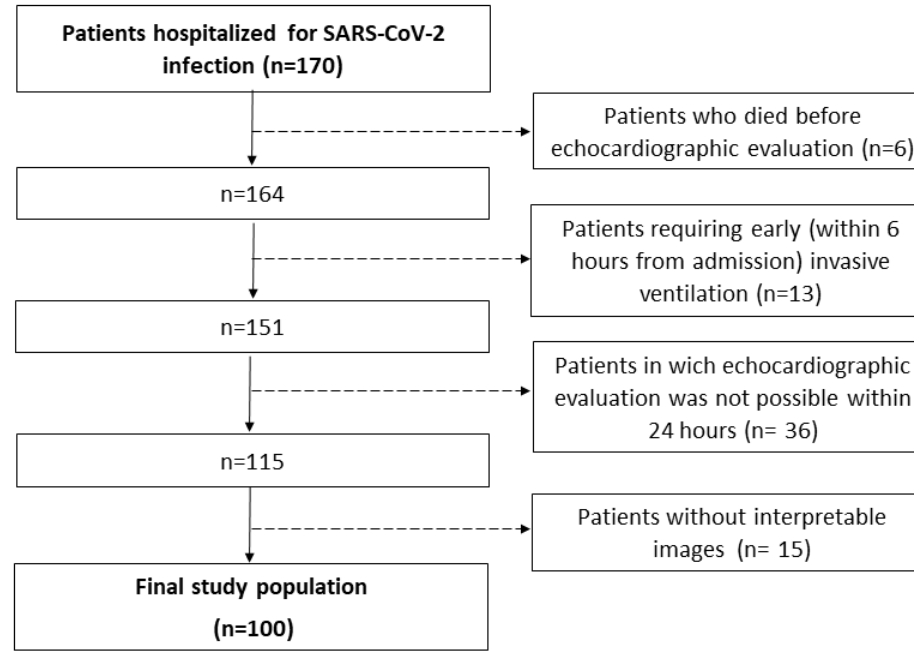
Figure 1. Flow diagram showing how the final study population was obtained.